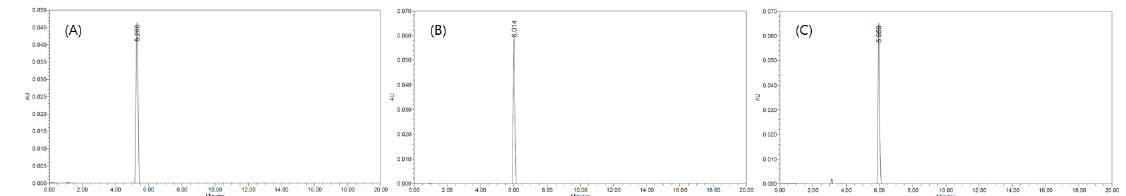
Figure 1. Change of high-performance liquid chromatography (HPLC) chromatograms of ethoxyquin by the C18 column varieties. ( A ) Phenomenex column, ( B ) Waters column, ( C ) Shiseido column.